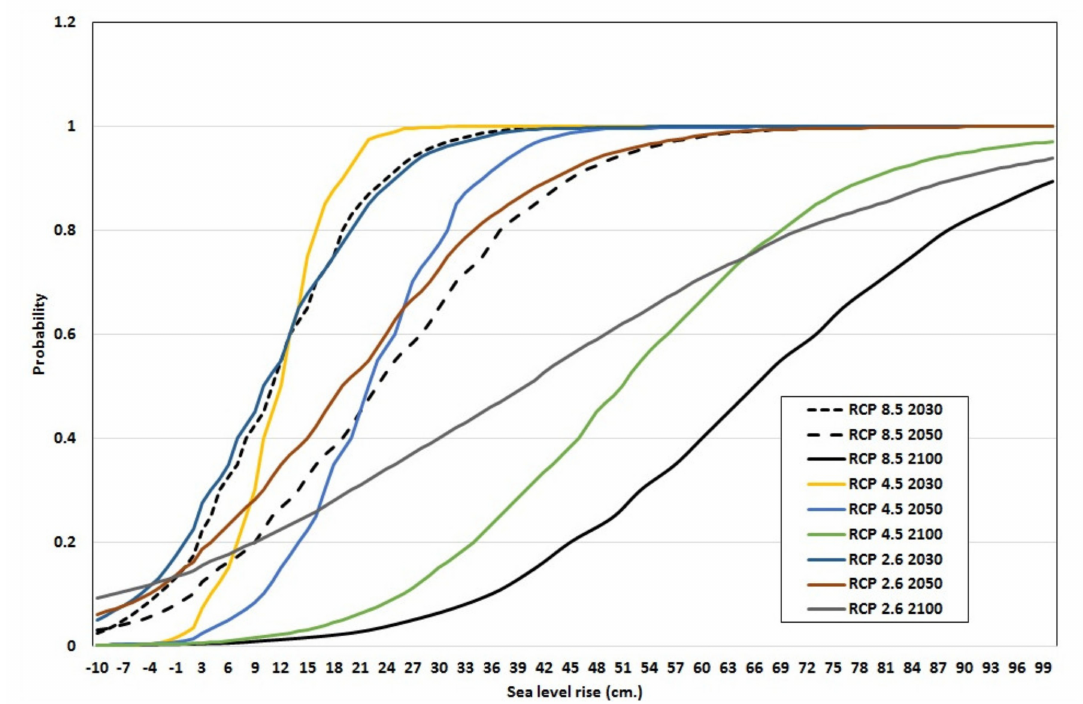
Figure 4. Evolution in time of the cumulative distribution function of sea-level rise in Barcelona under RCP 2.6, 4.5 and